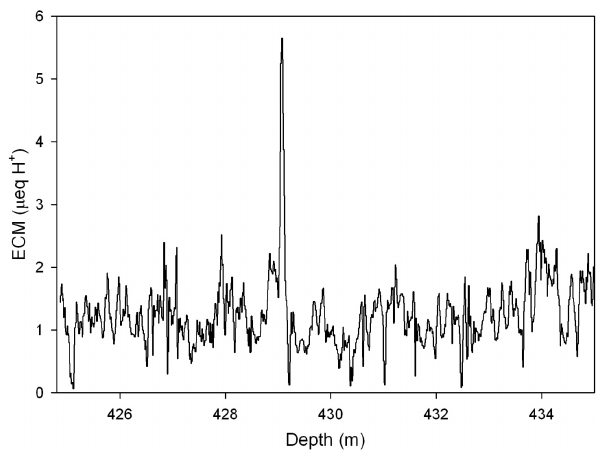
Fig. 1. Acid concentrations in the GRIP ice core determined by high-resolution electrical conductivity measurements (ECM) over 425–435m. The acid spike is attributed to the 79AD eruption in the GICC05 chronology (Vinther et al.,